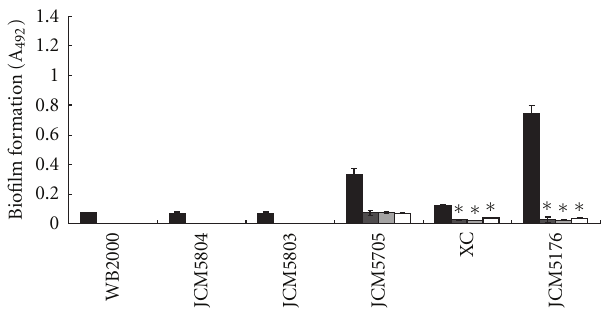
Figure 2: Inhibitory e ff ects of E. faecium WB2000 on biofilm formation by clinical mutans group streptococci. SMWs and SMF, clinical S. mutans strains; SSWs, clinical S. sobrinus strains. Black bars: single culture; white bars: dual culture with E. faecium WB2000. ∗ P < 0 . 05 versus single culture.